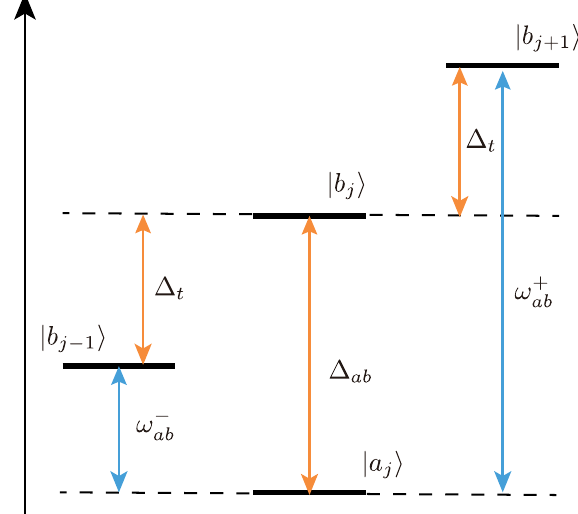
ba jj ba jj and Λ + − 1 1